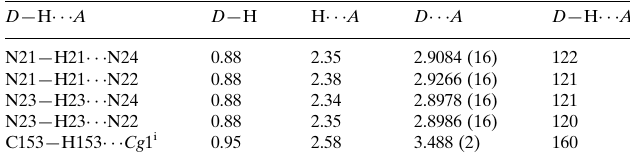
Hydrogen-bond geometry (A˚ , (cid:2)